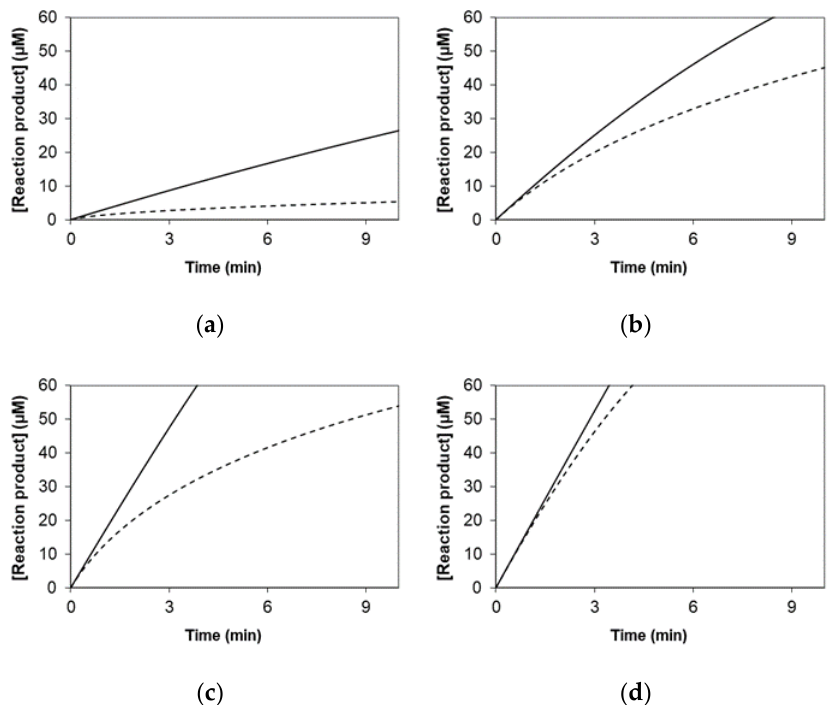
Figure 2. Theoretical simulation of product versus time curves with integrated equations assuming V max = 18 μM min −1 ; S 0 = 100 μM; and the following K m /K ic ratios: ( a ) K m /K ic = 1000; ( b ) K m /K ic = 5 (non-saturating conditions); ( c ) K m /K ic = 5 (saturating conditions); ( d ) K m /K ic = 0.4. The integrated equations utilized were without inhibition (solid line, Equation (1)) and in the presence of competitive inhibition by the reaction product (dashed line, Equation (2)).